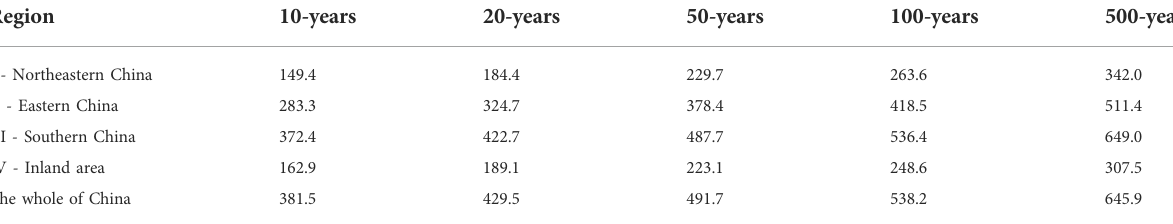
TABLE 4 Daily extreme TCP of 10-, 20-, 50-, 100-, and 500-years return periods. Region 10-years 20-years